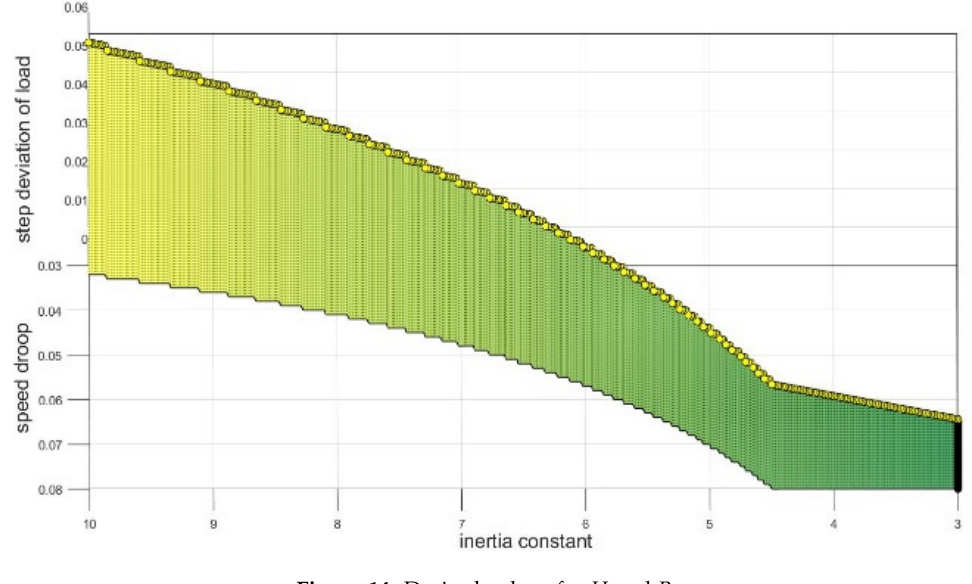
Figure 14. Desired values for H and R .